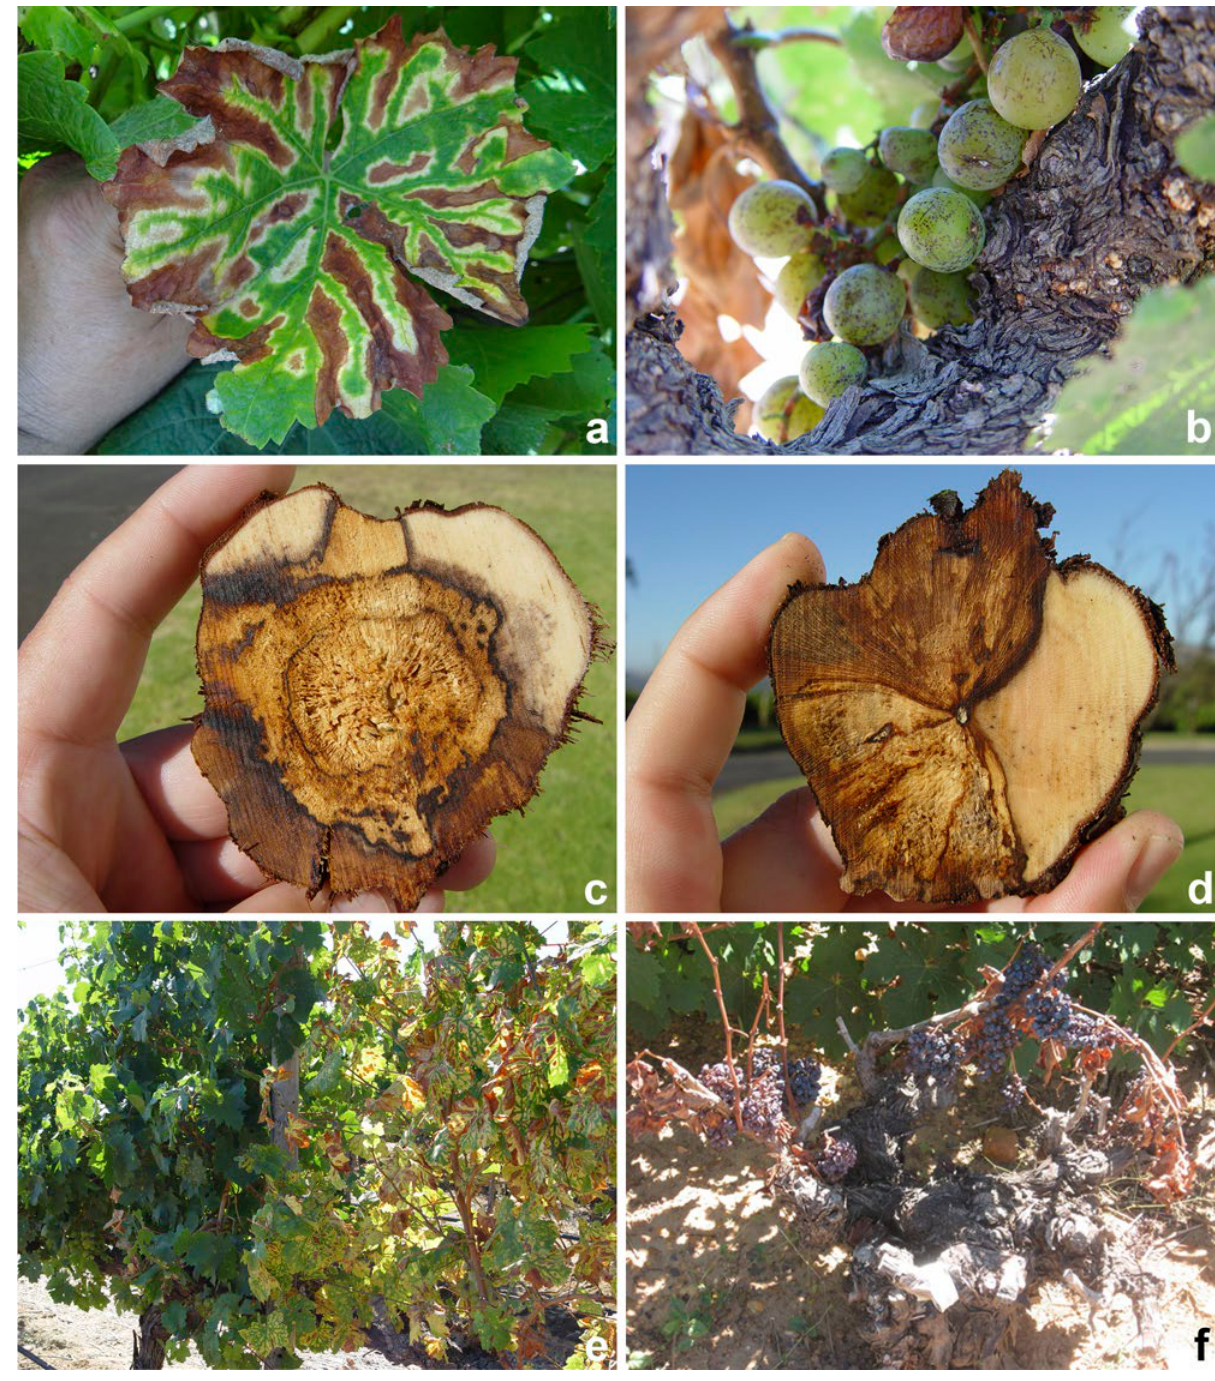
Figure 1. Symptoms on esca diseased grapevines in South Africa. a. Tiger stripe leaf symptoms on cv. Sauvignon blanc. b. “Black measles” on berries of cv. Hanepoot. c, d. White rot and internal wood symptoms on cv. Pinotage (c.) and Chardon- nay (d.). e. Leaf symptoms and decline on cv. Hanepoot. f. Apoplexy of a Cabernet Sauvignon vine (f. from White et al .,